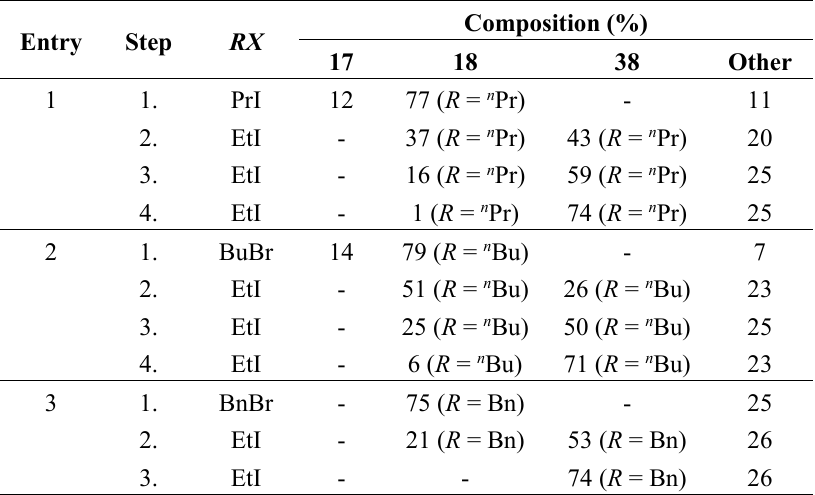
Table 12. MW-assisted synthesis of ethoxycarbonylmethylphosphonates with different alkyl groups ( 37